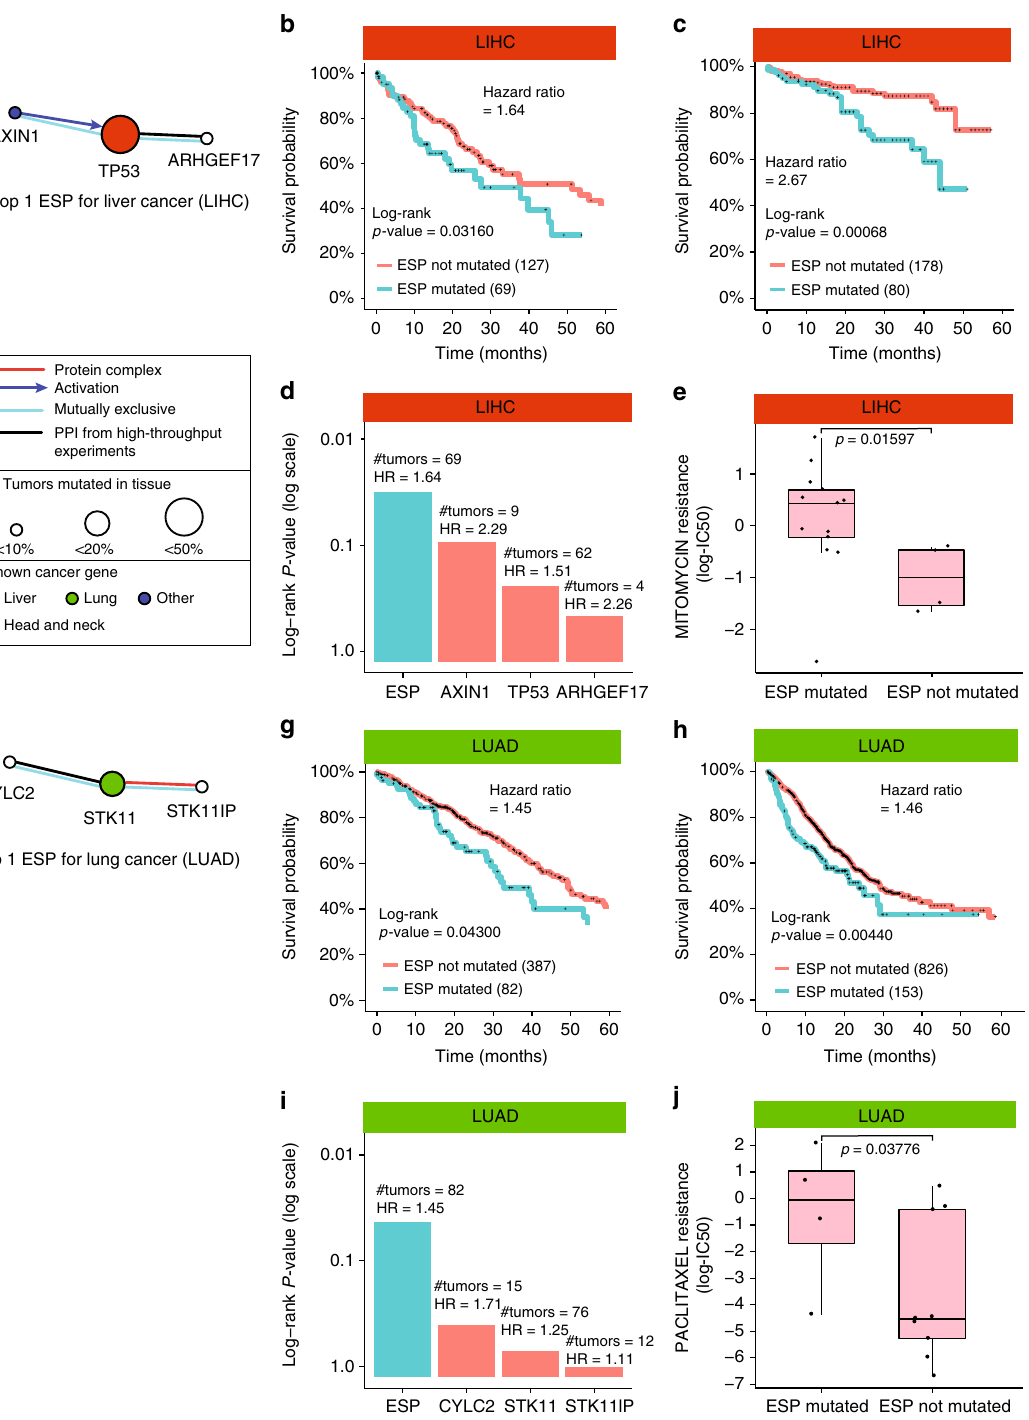
Fig. 6 Exploration and validation of mutated ESPs in multiple cancers. a Mutated ESP characteristic of liver cancer subtype 1/2. b Kaplan – Meier survival plot for the liver ESP shown in a on patients in TCGA (Methods). c Corresponding Kaplan – Meier survival plot for patients in ICGC. d Strati fi cation of patients using the aggregate of genes in the liver ESP vs. each of its genes individually. e Difference in drug resistance based on status of the ESP shown in a (Methods). Drug resistance is assessed by log(IC50) of liver cell lines in the GDSC dataset. p -value is calculated using a one-sided Wilcoxon signed-rank test. Box plots show the median, the 25th and 75th percentiles. f Mutated ESP characteristic of lung cancer subtype 1/5. g Kaplan – Meier survival plot for the lung ESP shown in f on patients in TCGA (Methods). h Corresponding Kaplan – Meier survival plot for patients in MSK-IMPACT. i Strati fi cation of patients using the aggregate of genes in the lung ESP vs. each of its genes individually. j Difference in drug resistance based on status of the ESP shown in f (Methods). Drug resistance and p -value are calculated the same as for ( e